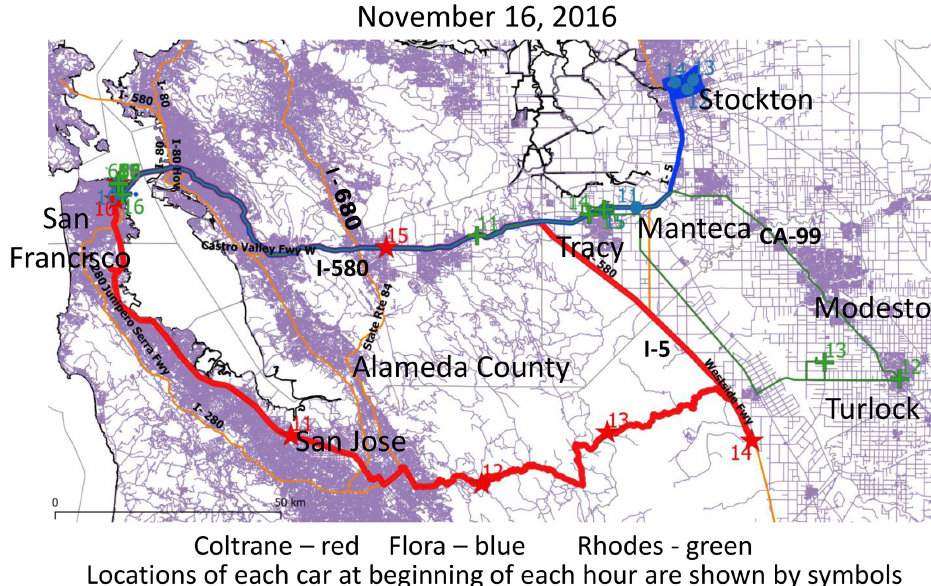
Figure 8. San Joaquin Valley driving routes on 16 November 2016. The positions of each car at the beginning of each hour are marked. The drives began and ended at the parking garage in San Francisco. Locations of cities identified in the text are also shown. Map generated